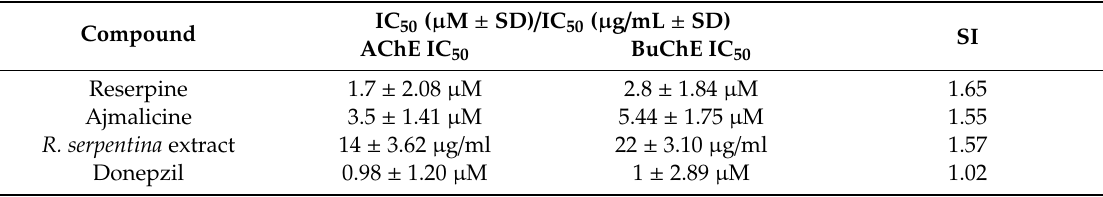
Table 4. Inhibitory activity (IC 50 ) and selectivity index (SI) of the compounds investigated against AChE and BuChE.